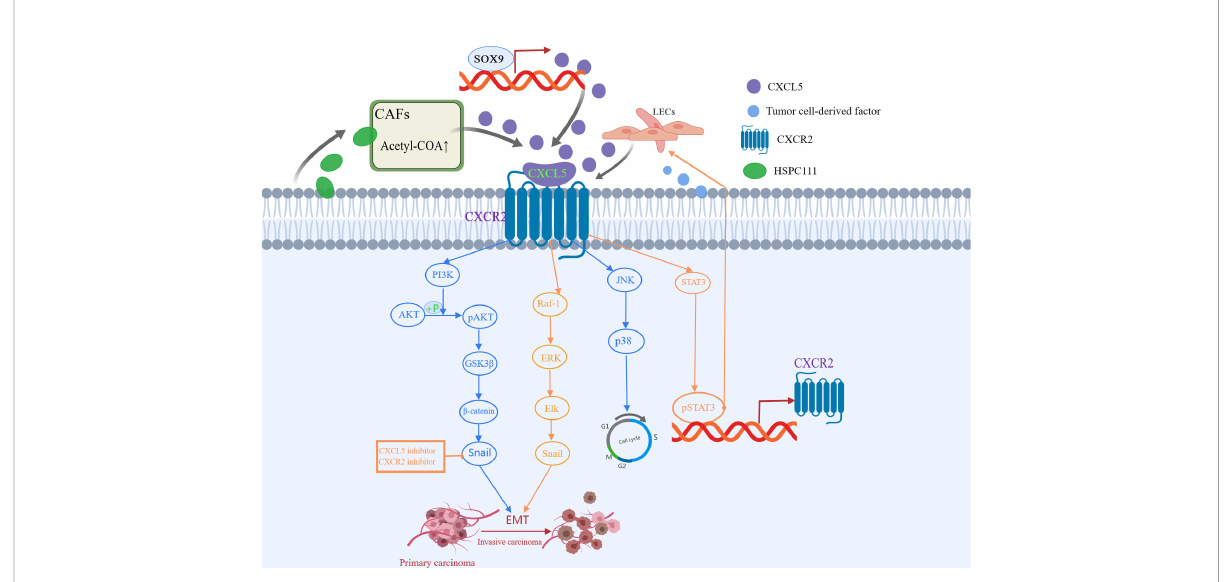
FIGURE 3 CXCL5 induced in various ways participates in different signaling pathways to promote tumor metastasis. CXCL5-CXCR2 axis is involved in the process of epithelial-mesenchymal transformation (EMT), invasion, and metastasis of cancer cells via the PI3K/AKT/GSK-3 b /Snail-Twist pathway, ERK/Elk-1/Snail pathway, as well as JNK and p38